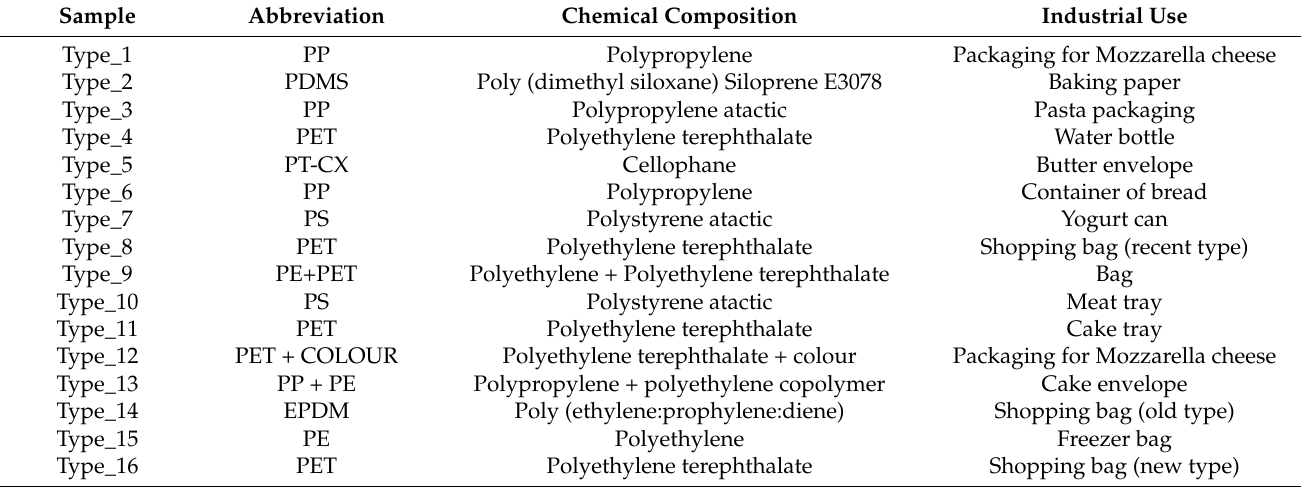
Table 1. Description of the packaging tested reported as “sample name”, chemical composition (with abbreviations) and industrial